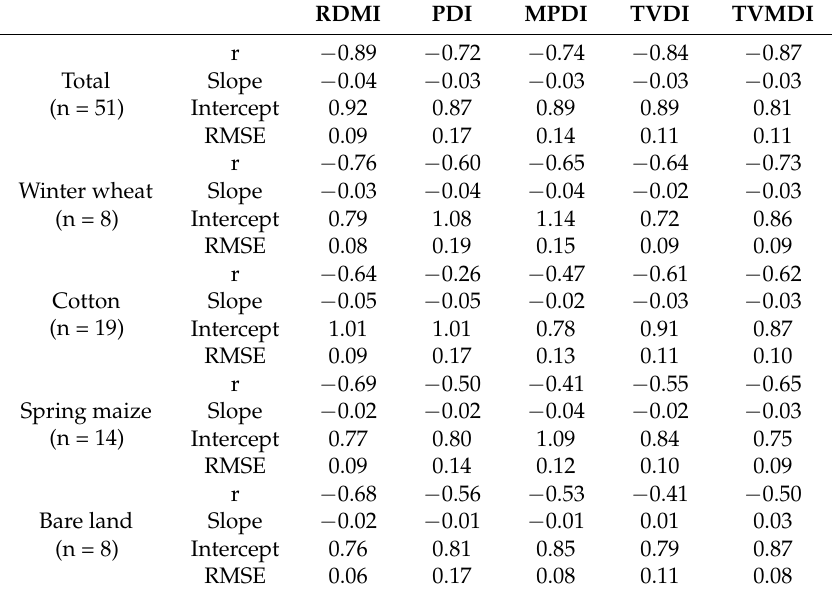
Table 4. The correlation coefficients, slope, intercept, and RMSE of RDMI, Perpendicular Drought cover conditions (n is the amount of in-situ data under this land cover).